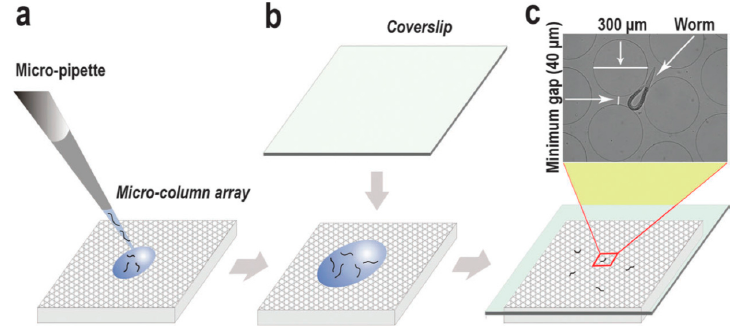
Figure 8. An array of micro-columns-based worm chip developed by Wang et al. [50] and the flow chart of the experimental procedure. ( a ) A pictorial representation of a worm chip in the process of worm-loading; ( b ) the addition of the cover slip; ( c ) the fate of the worm in the worm chip, whereby the worm is surrounded by micro-columns. Reprinted with permission from the Royal Society of Chemistry.